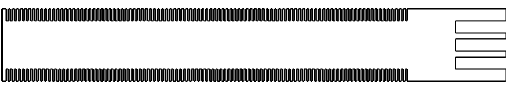
Figure 4. Geometry of slotted MCL with edge serrations.